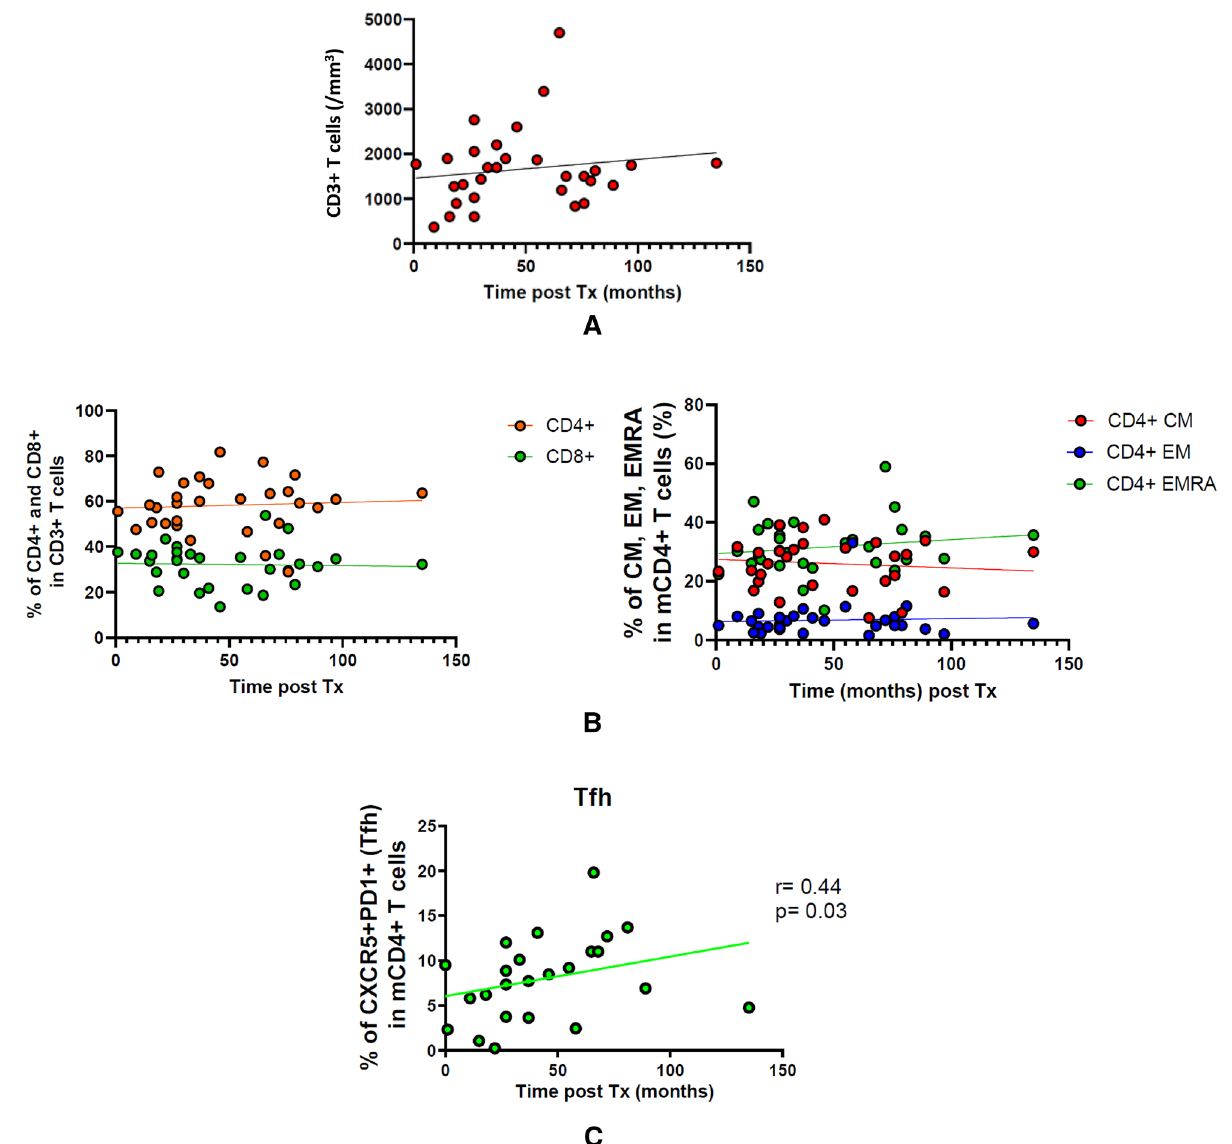
Figure 1. ( A–C ) Phenotype analyses of mCD4 + T cells. ( A ) CD3 + T cell number after transplantation. ( B ) CD4 + proportion among CD3 + (left) and memory T cell subsets of CD4 + (right). ( C ) Circulating T follicular helpers (due to blood sample availability, only 24 patients were